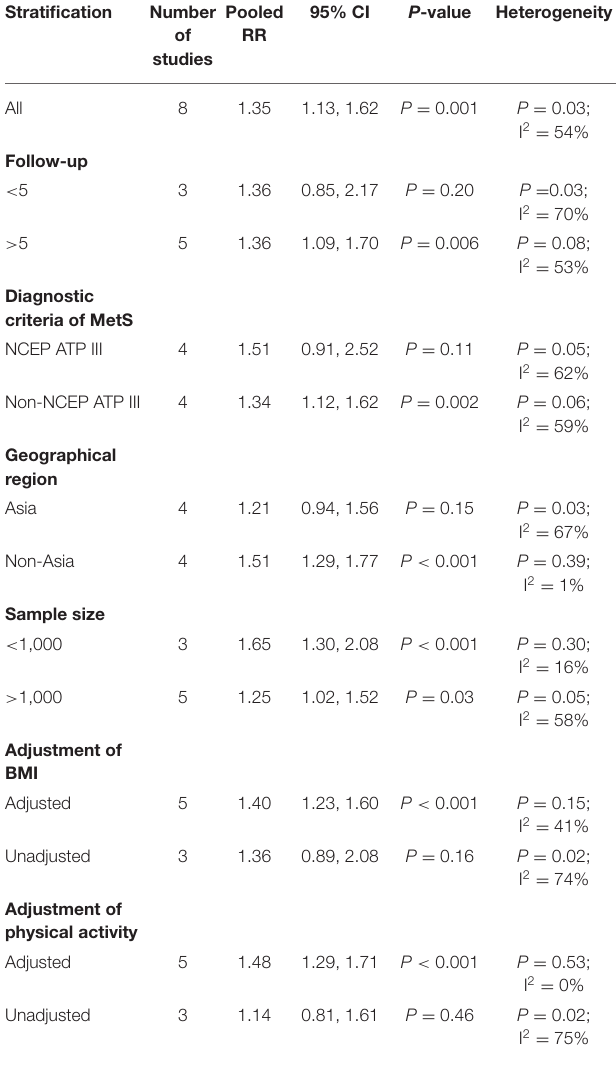
TABLE 2 | Subgroup analysis of relationship between red meat consumption and risk of